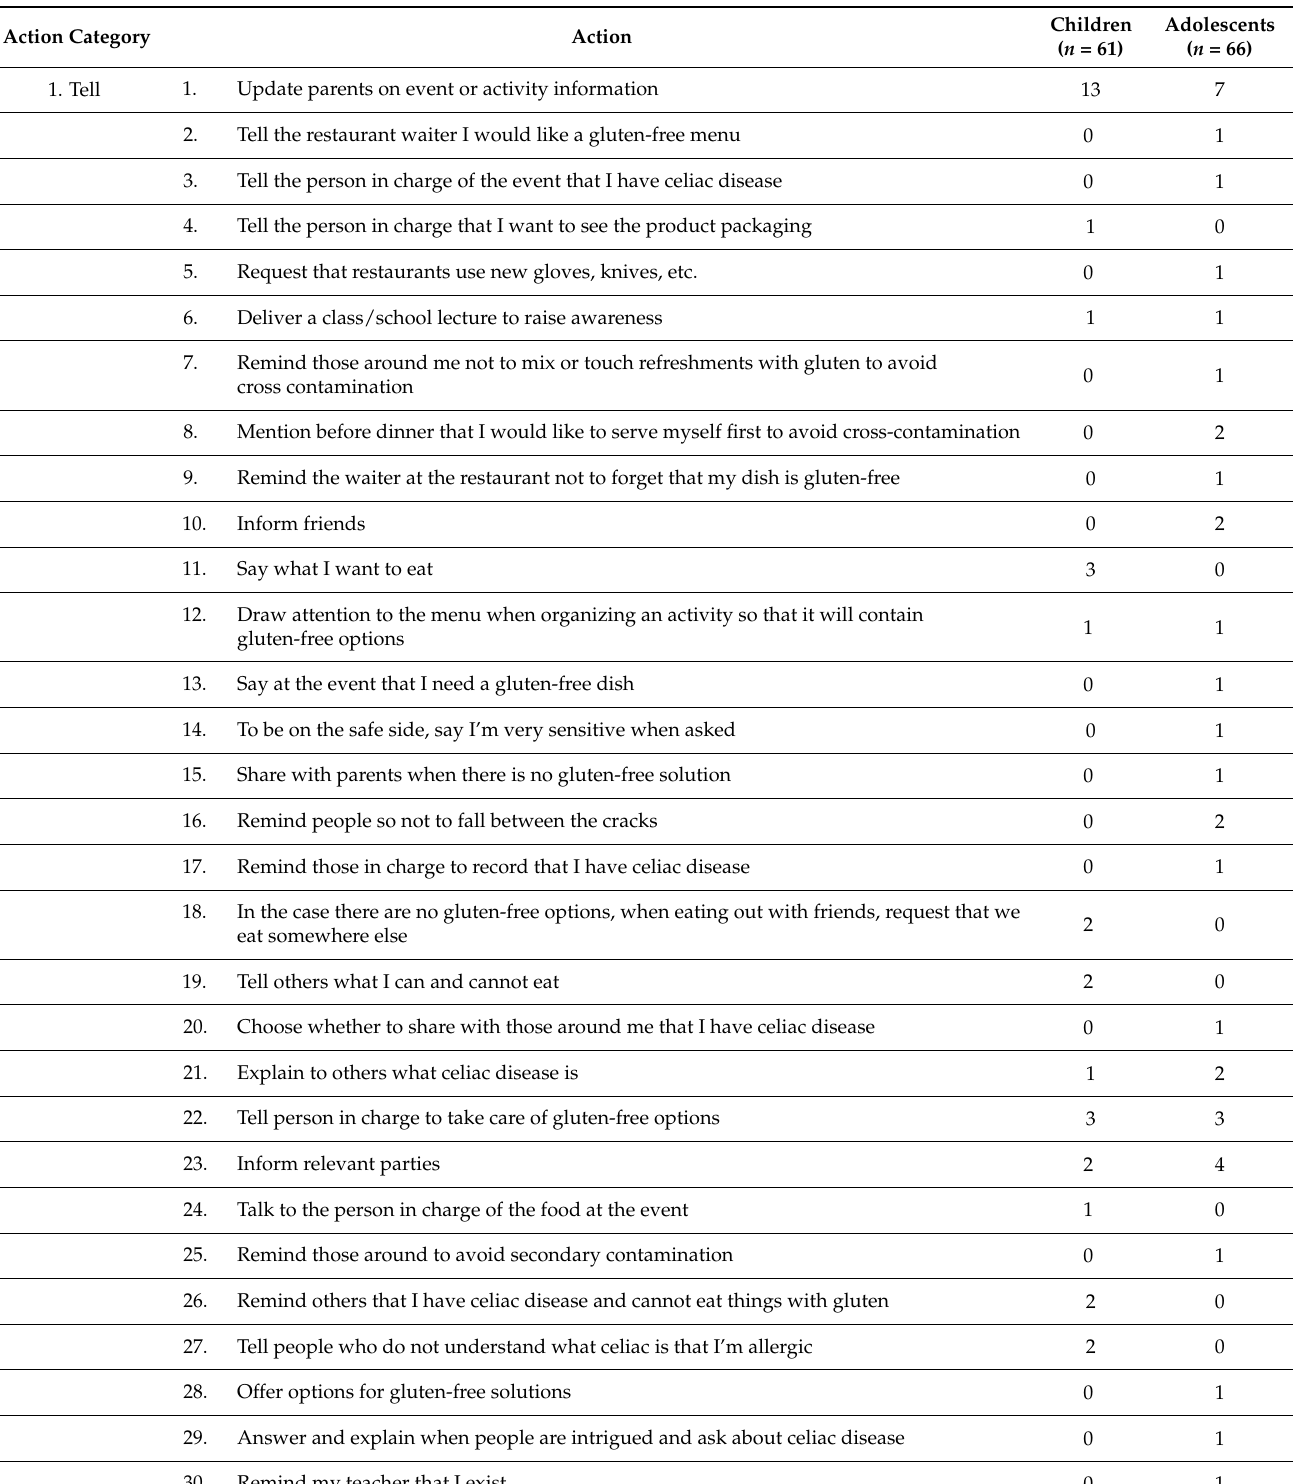
Table 1. Do and don’t actions and 10 action